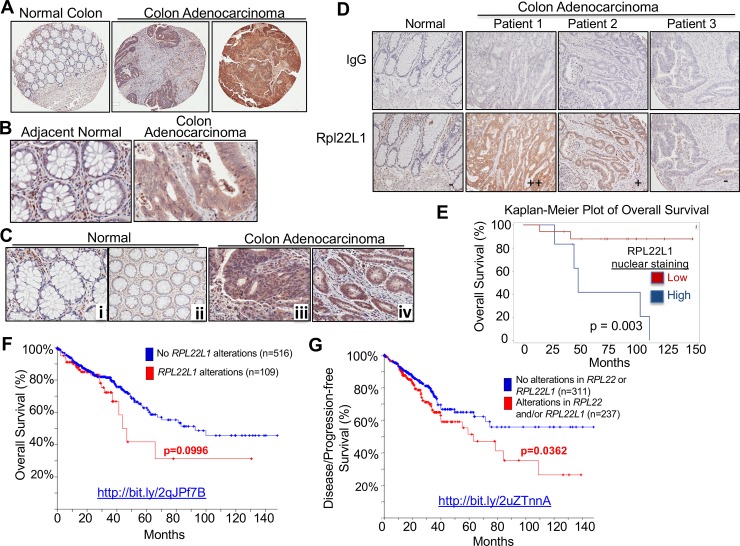
High expression of Rpl22L1 is correlated with poor survival in CRC.A-B. Representative pictures from a CRC tissue microarray (TMA) show that RPL22L1 is highly expressed in colon adenocarcinoma compared with normal colon at 4X magnification (A) and 20X magnification (B). C. RPL22L1 staining is increased in the cytoplasm (iii) and nucleus (iv) of colon adenocarcinoma compared with normal controls (i-ii), which mainly exhibit stromal staining. D. RPL22L1 expression is variable in different colon adenocarcinoma samples (“-“, negative; “+”, weak positive; and “++”, strong positive). IgG serves as antibody negative control. E-G. Kaplan-Meier analysis of Overall Survival in 23 colon cancer patients using Rpl22L1 IHC data from TMA analysis (OS: E, p = 0.003) or genomic alterations in 625 colon cancer patients from the TCGA provisional data set (OS; F, p = 0.0955). Kaplan-Meier analysis of Disease/Progression-free Survival (G, p = 0.0363) revealed that patients with Rpl22L1 alterations (copy number gain and two-fold greater upregulation) and/or alterations in RPL22 have reduced survival when compared with patients without those alterations. Web links to the TCGA data are embedded in the figure panels.